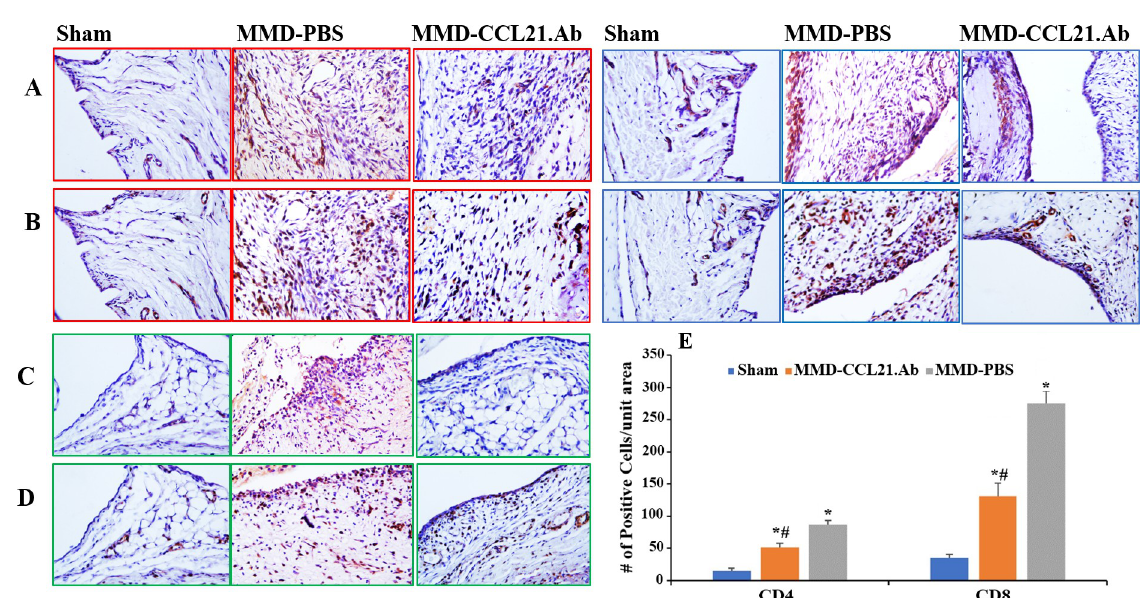
Fig 10. MMD induced T cell infiltration to rat injured knees and treatment with CCL21-Ab reduced the number of CD4+ and CD8 + cells in MMD-knees at day 3 post surgery. Images of areas from knee joints’ synovial tissues collected from; Sham-, control MMD-knees treated with PBS (MMD-PBS). and MMD-knees treated with CCL21-Ab (MMD-CCL21.Ab). Histology sections collected from rat knees at day 3 post-surgery were used. Immuno-histochemistry staining was performed using rat CD4 (A and C) and CD8 (B and D) antibodies, and counterstained with hematoxylin. Images in red squares represent areas from medial side of knee joints. Images in blue squares represent areas from collateral side of the knee joints. Images in green squares were taken at the frontal end of joint capsule, near the connection of the Patella ligament with femur. The exact position in knee joints is indicated in S1 Fig. The graph in the right bottom panel represents the number of positive stained cells per unit area at the joint capsules (E). Data are expressed as number of positive stained cells per unit area and are presented as mean ± SE. � P < 0.05 vs Lk sham-operated knees. #P < 0.05 vs MMD-saline, n = 5–6